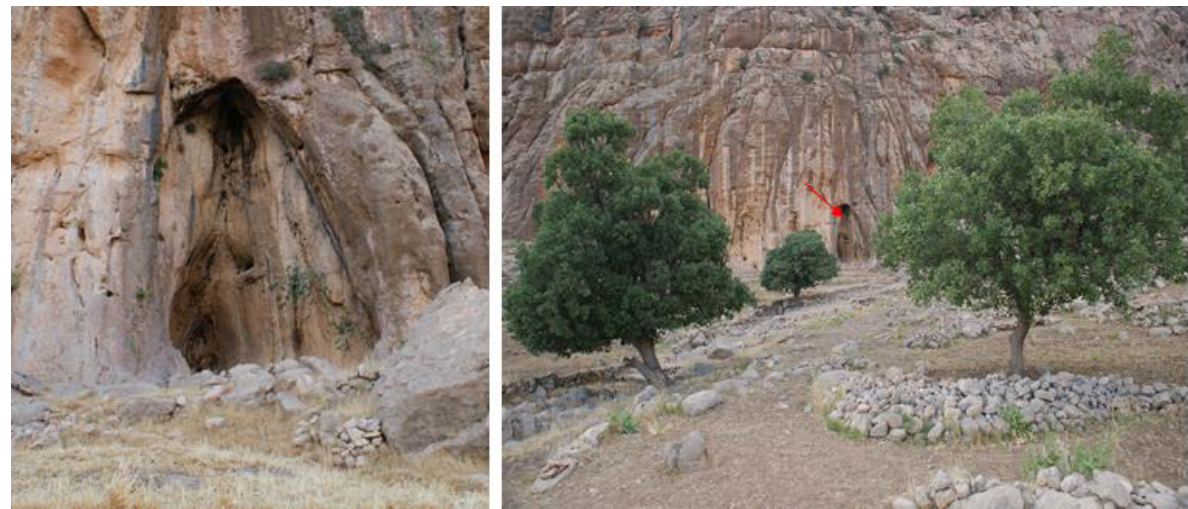
Figure 2. View of the Shamsali Rock shelter located 150 m northwest of